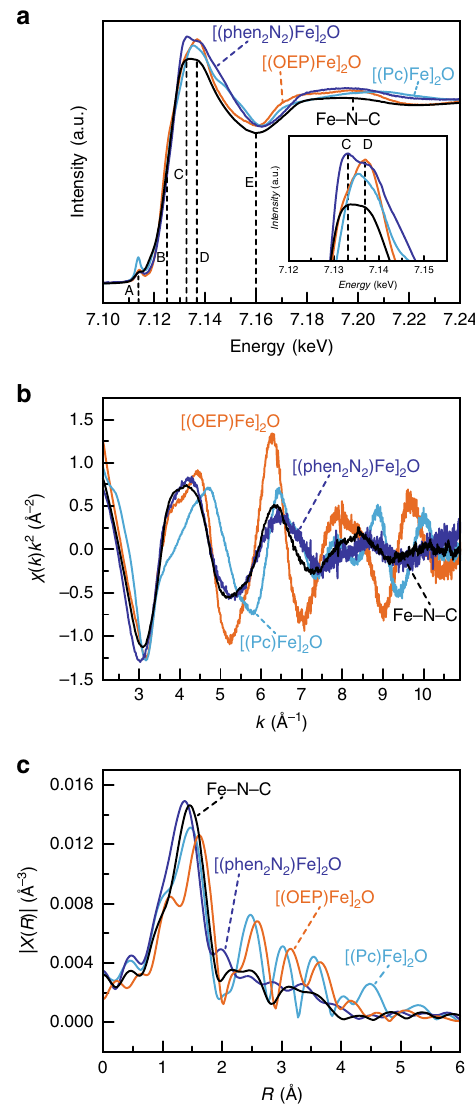
Fig. 4 X-ray absorption spectroscopy data. XANES spectra ( a ) and expanded main-edge region (inset), k 2 -weighted Fe k-edge EXAFS spectra ( b ) and k 2 -weighted Fourier transform Fe EXAFS spectra ( c ). The energy values of the vertical lines and the alphabetical labels in ( a ) are taken from reference 70 . Fe-N-C is shown in black, [(phen 2 N 2 )Fe] 2 O in blue, [(OEP) Fe] 2 O in orange and [(PcFe)] 2 O in